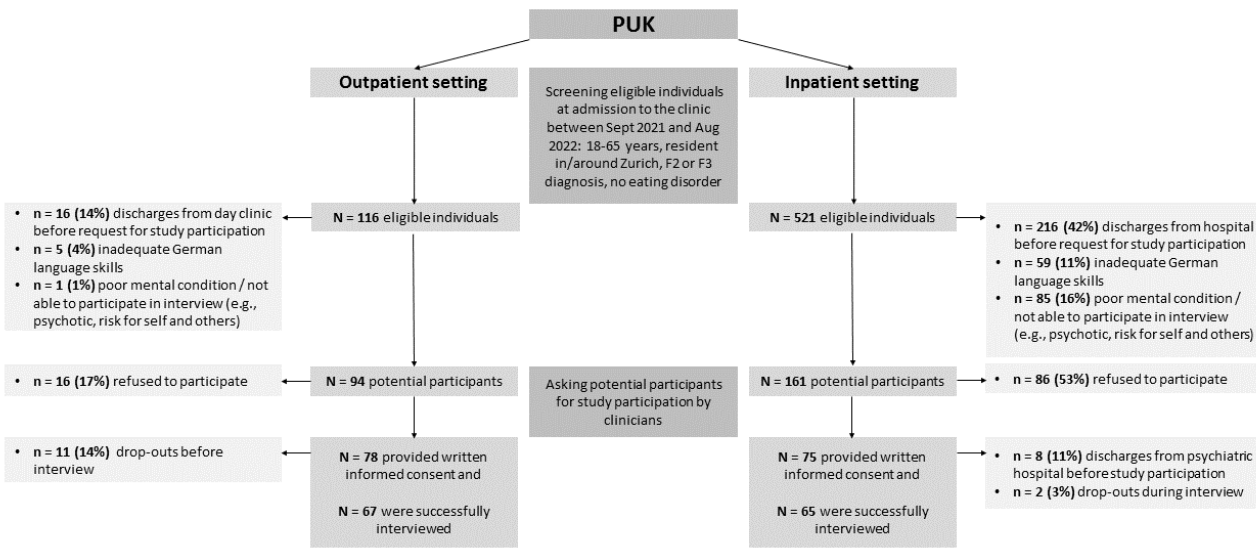
Figure 1. Flowchart of the participants’ inclusion process.